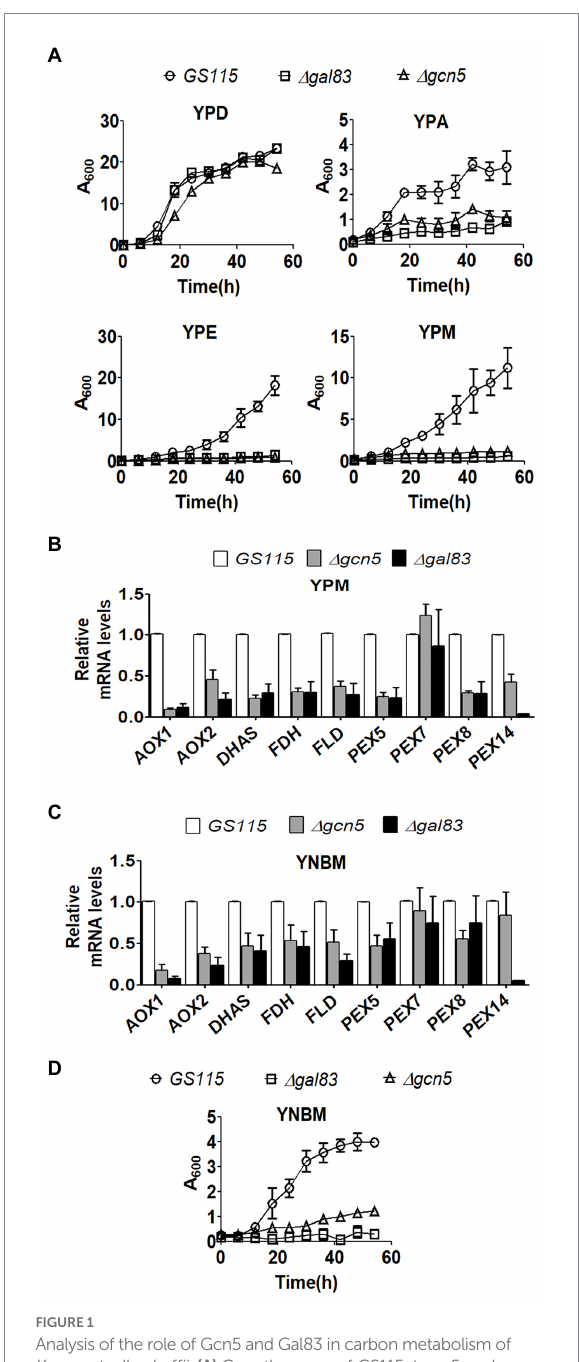
FIGURE 1 Analysis of the role of Gcn5 and Gal83 in carbon metabolism of Komagataella phaffii . (A) Growth curves of GS115, Δ gcn5, and Δ gal83 . Cells were cultured in different media as indicated. Error bars in each figure indicate S.D. n = 3. (B) Analysis of mRNA levels of key genes of MUT pathway by qPCR in different K. phaffii strains cultured in YPM for 6 h. (C) Analysis of mRNA levels of key genes of MUT pathway by qPCR in different K. phaffii strains cultured in YNBM for 6 h, as indicated. (D) Growth curves of GS115, Δ gcn5, and Δ gal83 cultured in YNBM. Error bars in each figure indicate S.D. n =